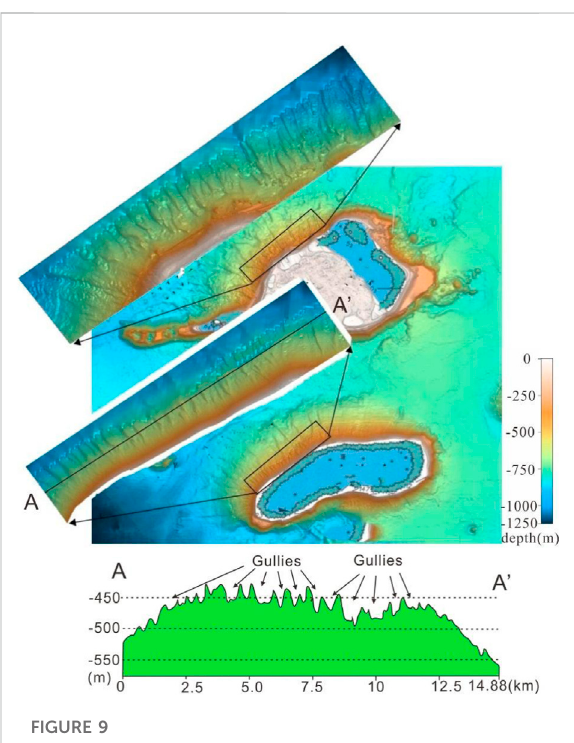
FIGURE 9 Three dimensional topographic diagram of erosion scouring trough, AA ’ is the water depth pro fi